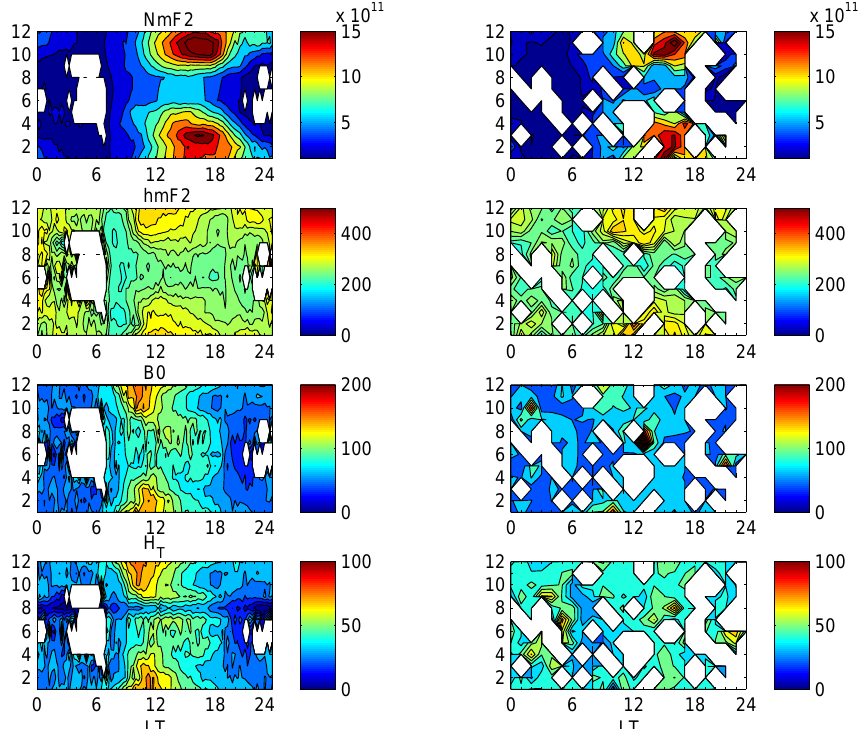
Fig. 2. Variations in Nm F2, hm F2, B 0, and H T values measured from ground-based observations (left panels) and RO measurements (right